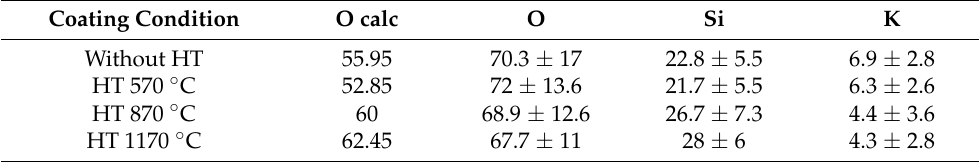
Table 3. Results of the elemental analysis of the coating material, normalized to carbon (at.%). Coating